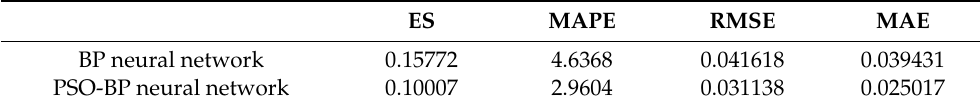
Table 8. Error comparison of evaluation indicators of the 26 training sets.